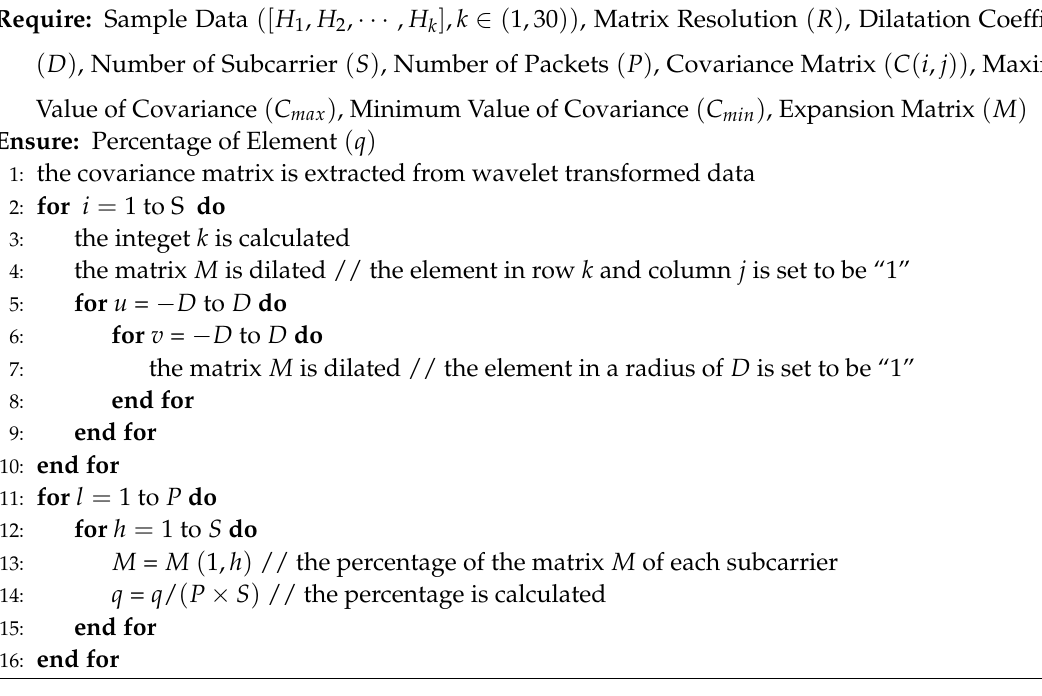
Algorithm 1 Crowd Counting based on Channel State